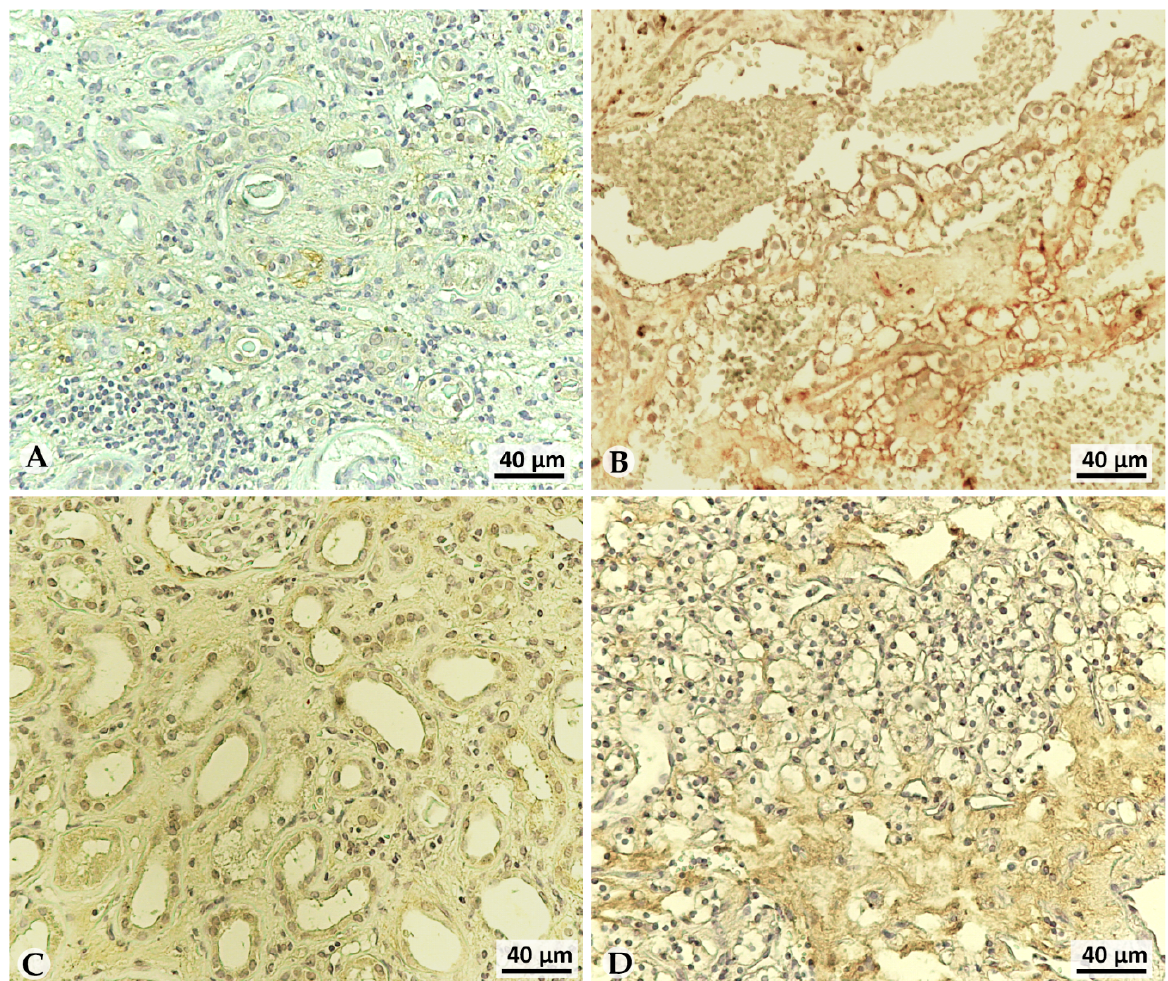
Figure 4. VEGF-A and LOX-1 immunohistochemistry analysis in NpT and tumoral tissues. ( A – C ) NpT tissues, ( B , D ) G2 tumoral tissue, ( A , B ) Immunohistochemistry of VEGF expression, ( C , D ) LOX-1 expression in high grade is present also in the extracellular space. Scale bar 40 μm.